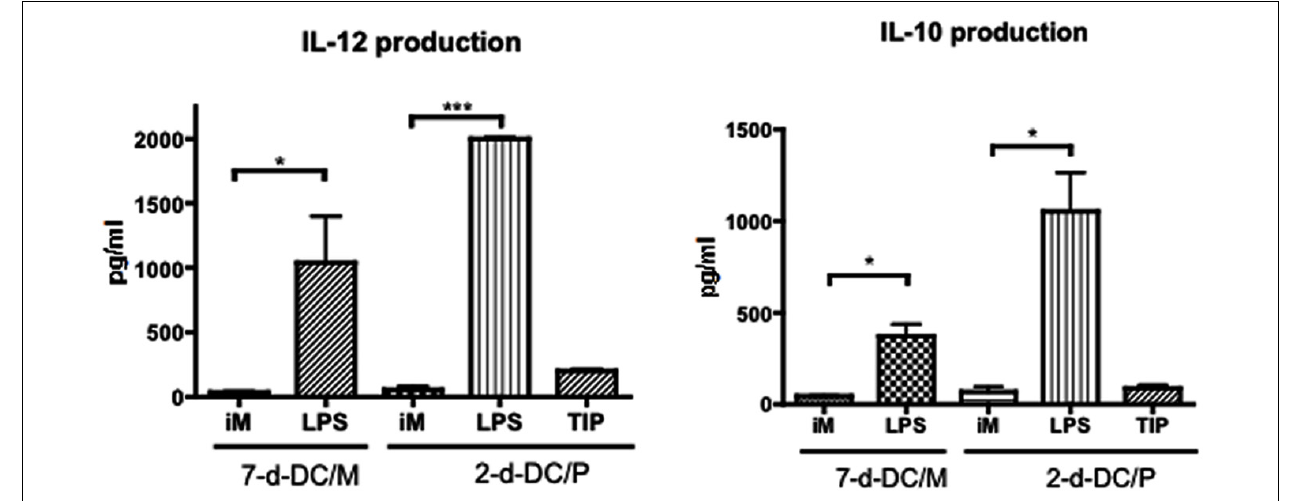
FIGURE 2 | Production of cytokines by the 2-day-DC/PBMC. The levels of IL-12 (bioactive p70 heterodimer) and IL-10 in the supernatants from MDDCs (7-d-DC/M) or 2-day-DC/PBMC (2-d-DC/P) either non-matured (iM) or matured